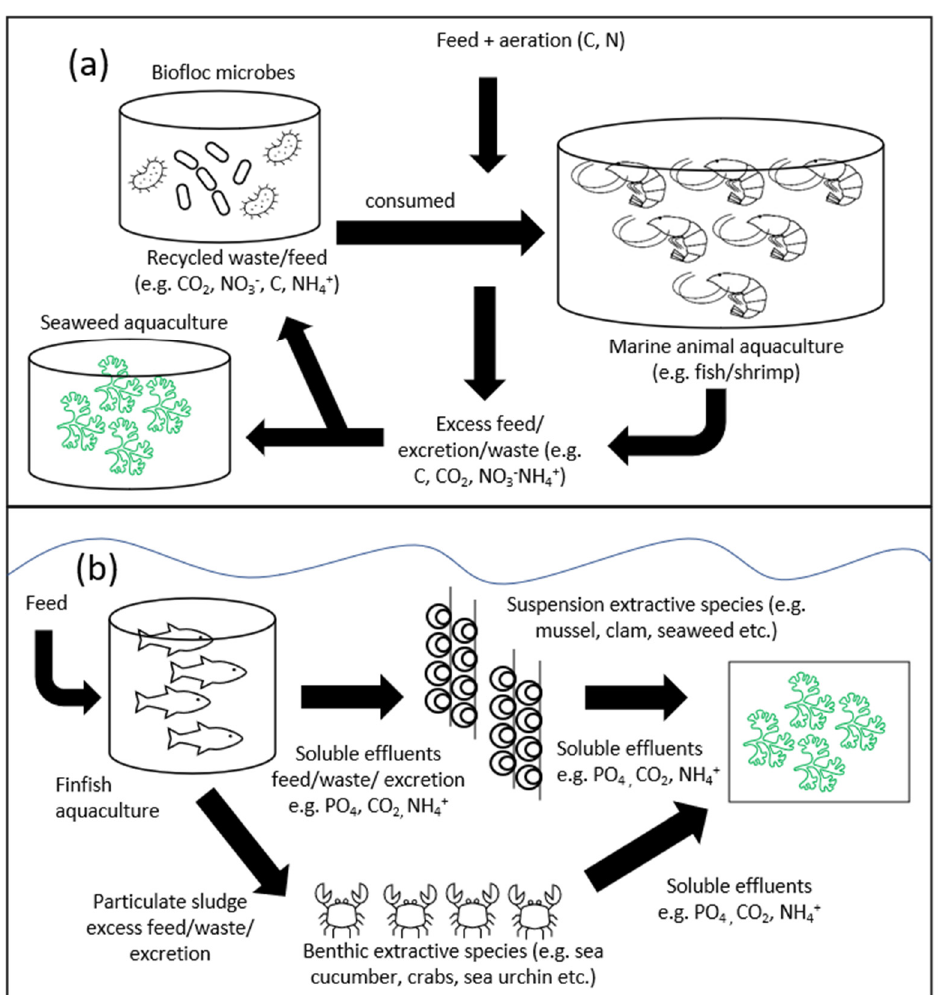
Figure 5. ( a ) A schematic diagram of a biofloc system implemented in an aquaculture enclosure. Co-cultivation of seaweed and biofloc microbes in the aerated system can consume and recycle excess feed and waste from the aquaculture species. ( b ) An IMTA system consisting of multiple species acting as extractors in which both can be adapted to improve seaweed growth rate and biomass